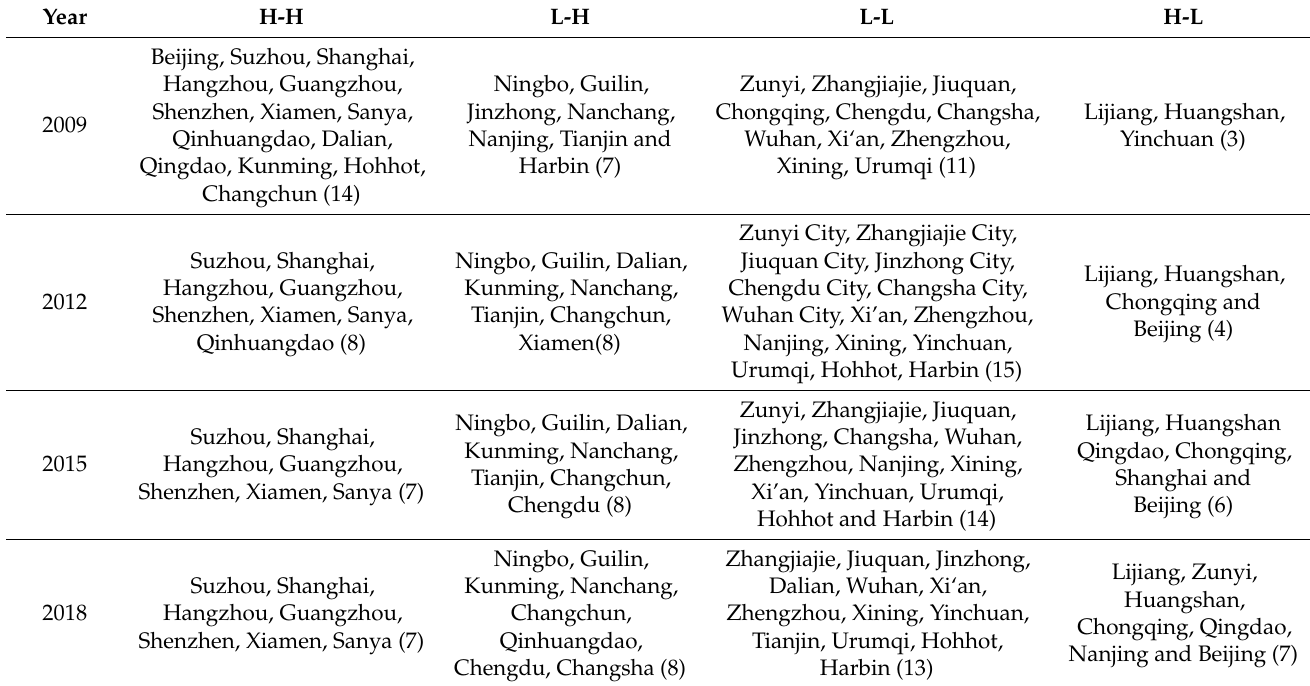
Table 3. The types of local spatial autocorrelation of the tourism urbanization indexes of major tourist cities in China.